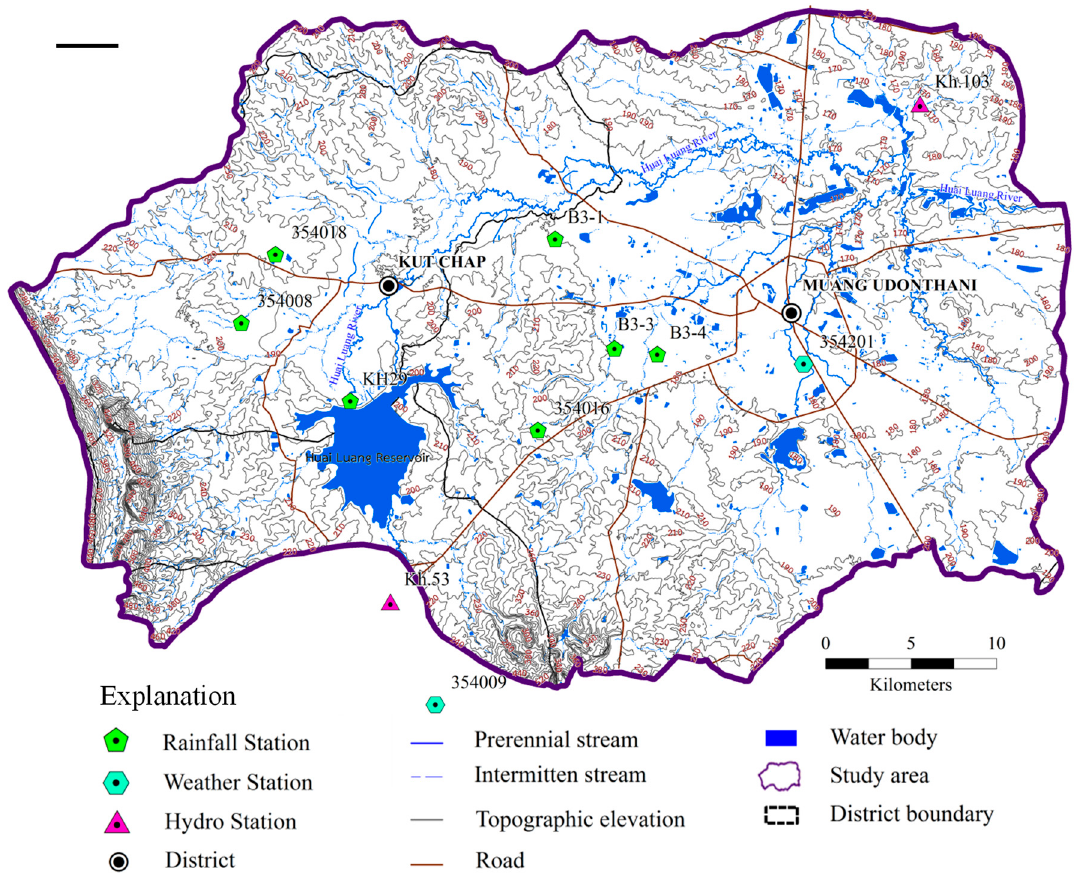
Figure 2. Topographic elevations (MAMSL) and meteorological and hydrological stations in the CHLB .